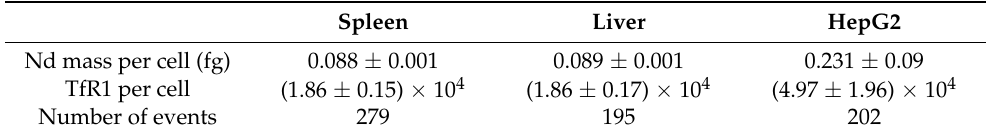
Table 1. The average Nd mass per cell and the average number of TfR1 per cell that were obtained by single cell ICP-MS after cell tagging with the labelled